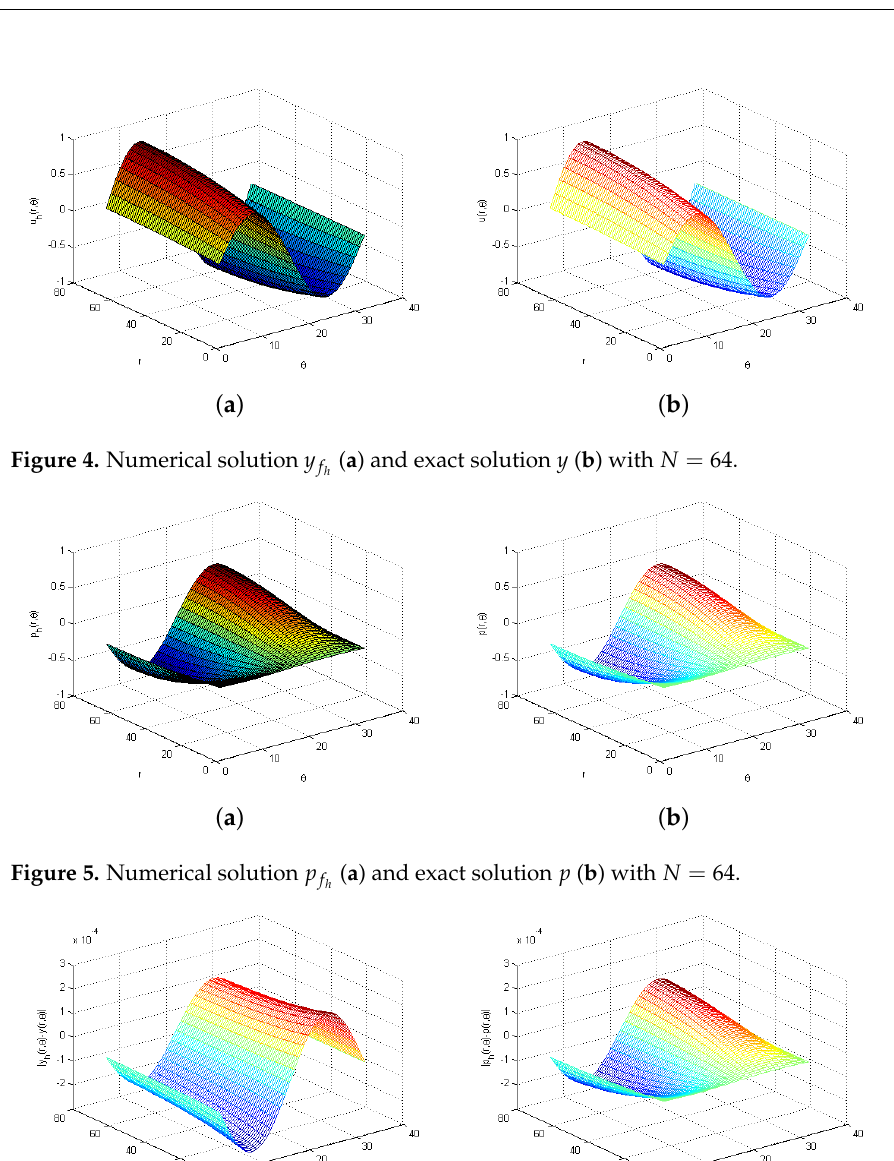
Figure 6. Error for state y ( a ) and adjoint state p ( b ) with N =